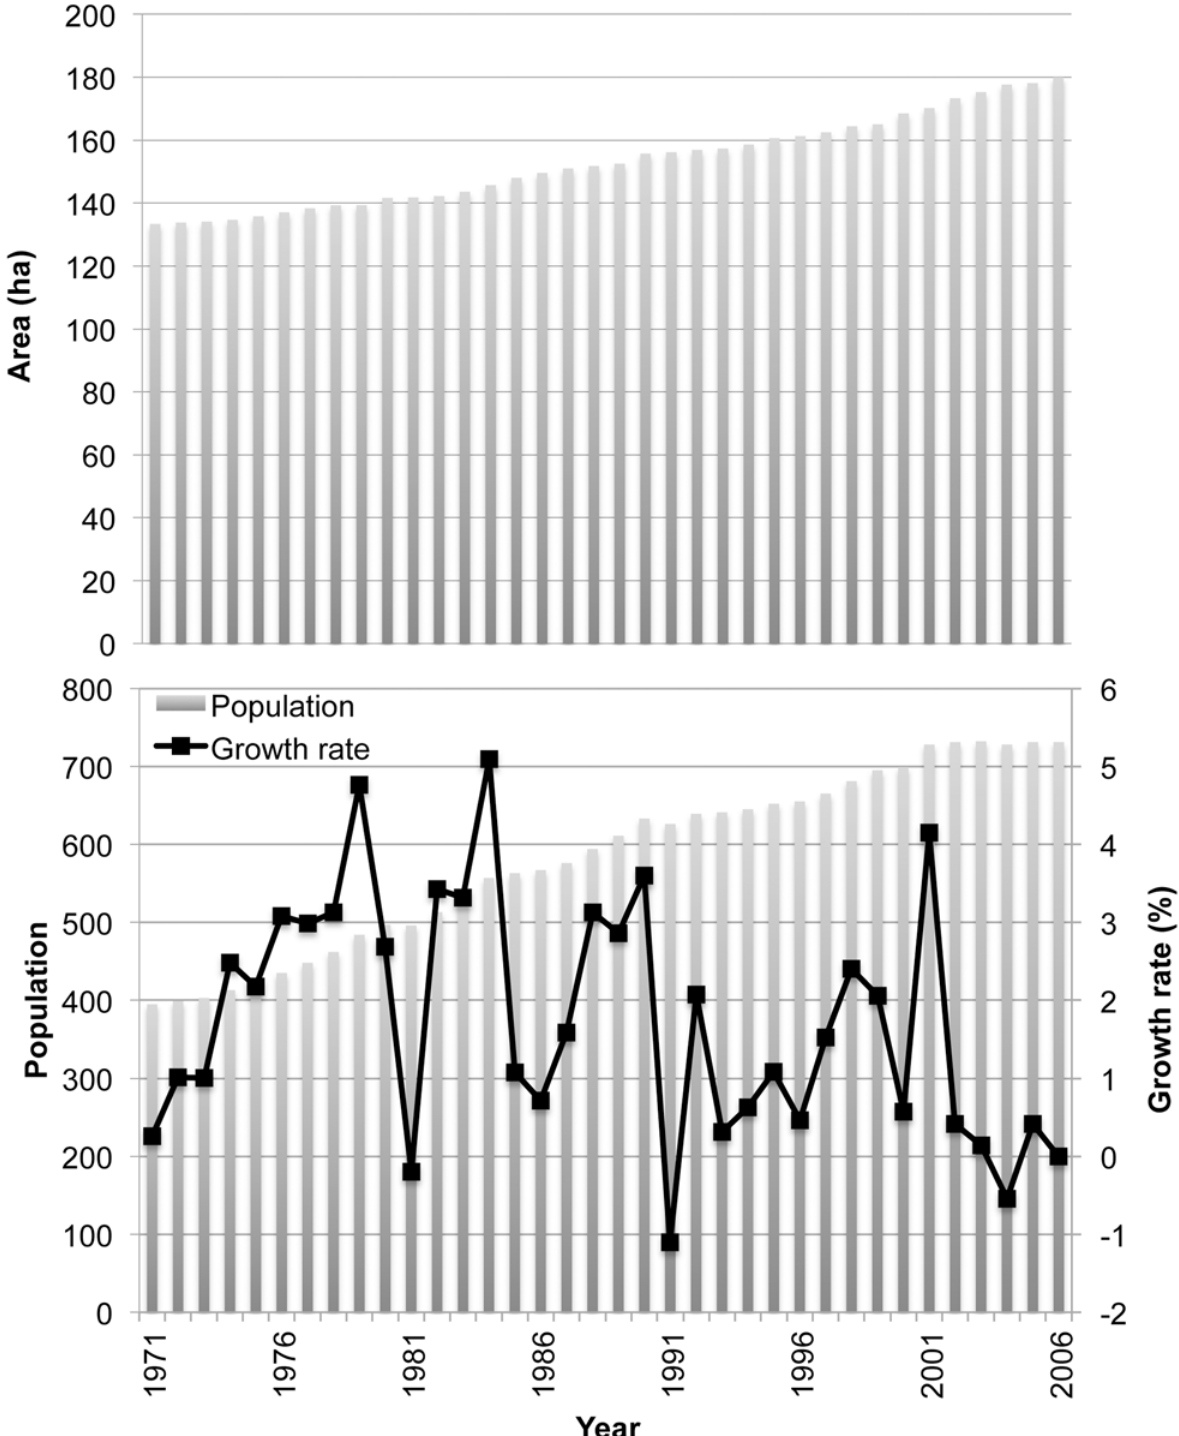
Fig 4. Growth in the total area of irrigated rice fields (top) and in village population (bottom) in Na Savang 1955 – 2006.